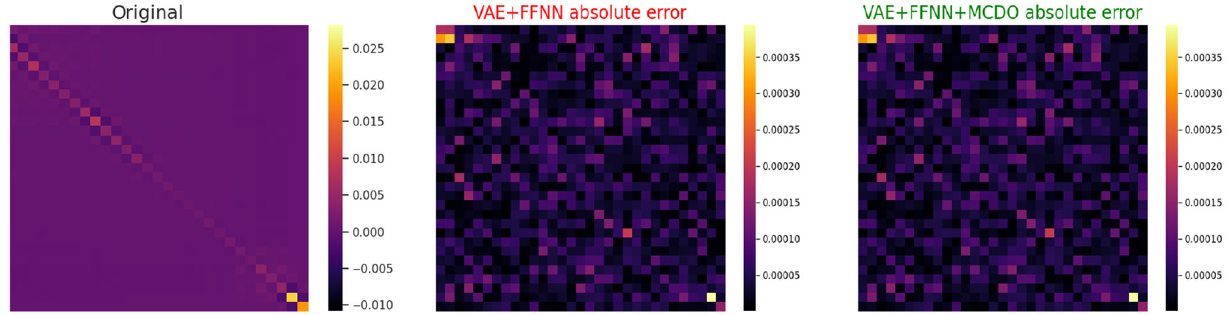
Fig. 5 Left: Original covariance matrix with systematic errors from JLA compilation (binned version) with 961 entries. Middle: Absolute error for the covariance matrices predicted by the VAE+FFNN concern-